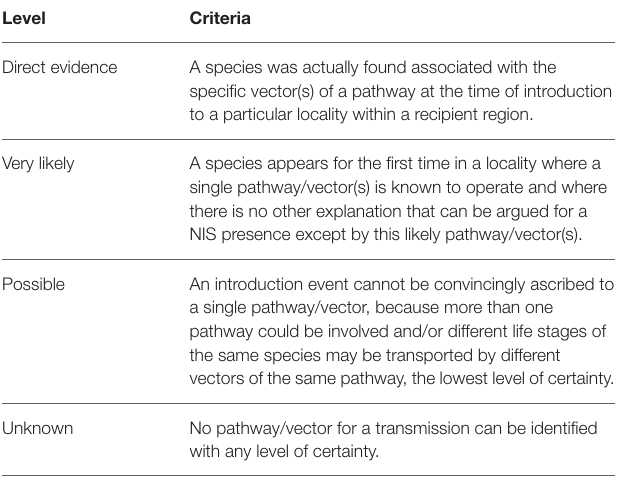
TABLE 2 | Levels of certainty applied for pathways and vectors in